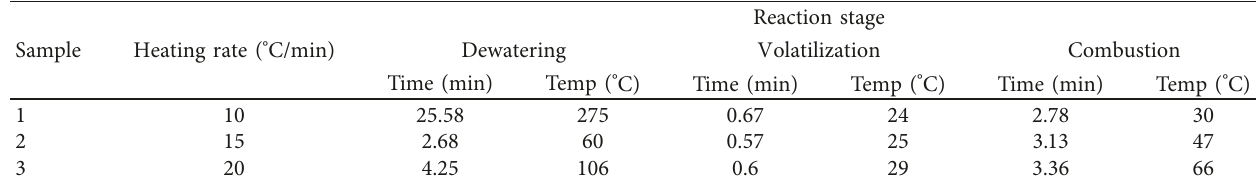
Figure 1: Rate of petcoke weight loss (%) vs. (a) temperature ( ° C) and (b) time (min) for different samples. The gray area shows the range in which our implementations for petcoke combustion were applied. Table 4: Reaction stages